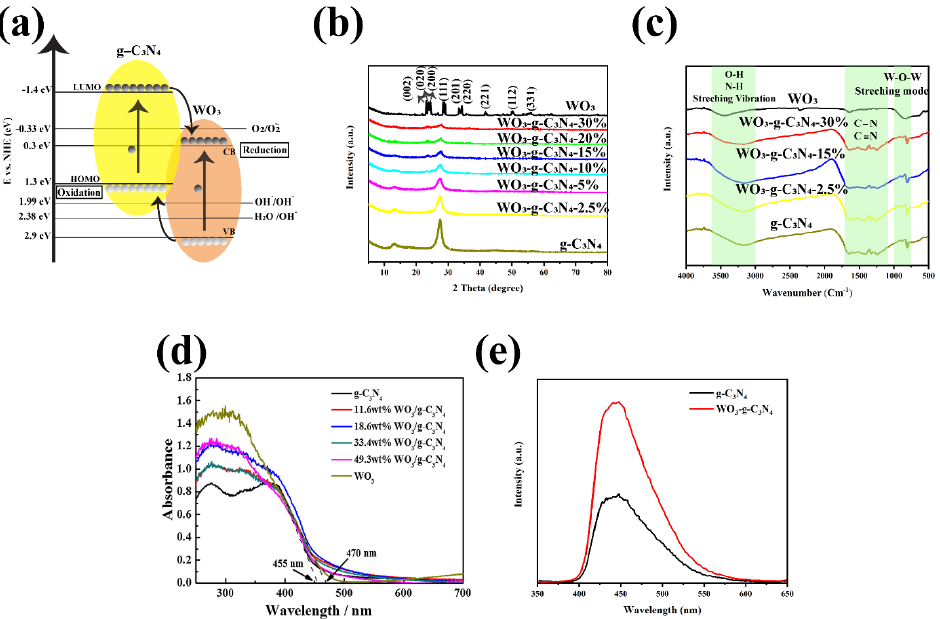
Figure 15. ( a ) Proposed structure of g-C 3 N 4 -WO 3 heterojunction interface; ( b ) XRD patterns and ( c ) FT-IR spectra of obtained samples (x in WO 3 /g-C 3 N 4 refer to the mass ratio of WO 3 to g-C 3 N 4 ), Copyright © 2022 Elsevier [251]; ( d ) UV-DRS spectra of pure g-C 3 N 4 , WO 3 and WO 3 / g-C 3 N 4 heterojunctionp; ( e ) PL emission spectra of g – C 3 N 4 and 18.6 wt % WO 3 / g-C 3 N 4 composite, Copyright © 2022 Elseviers [254].